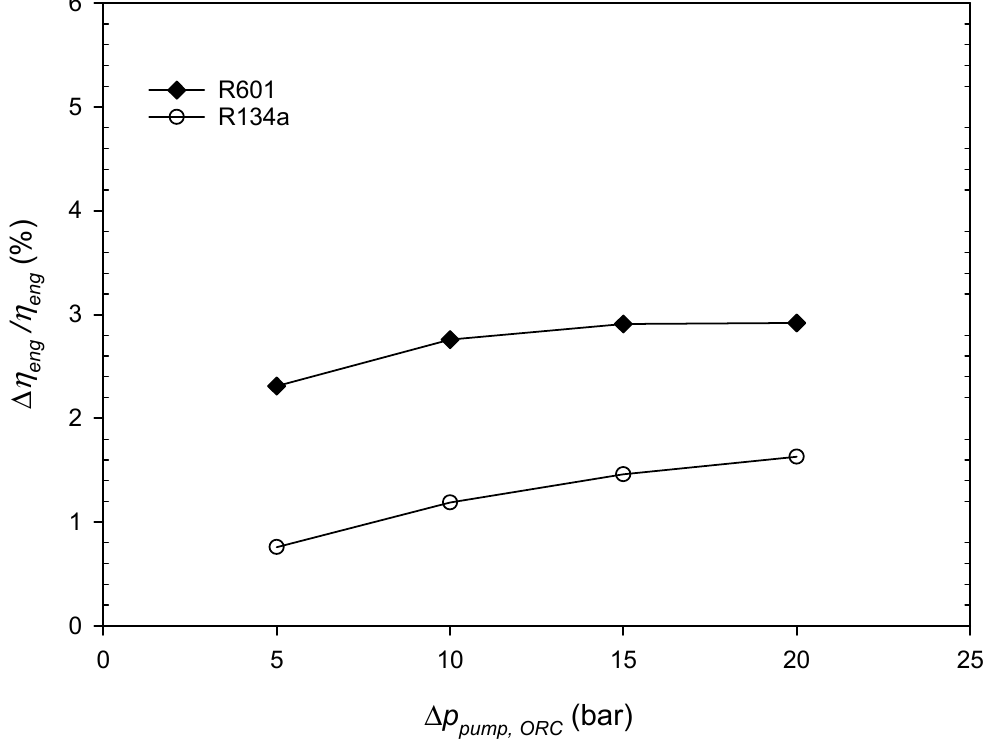
Figure 11. Engine e ffi ciency increment as a function of the pump pressure increase, grid point Figure 11. Engine efficiency increment as a function of the pump pressure increase, grid point 6.